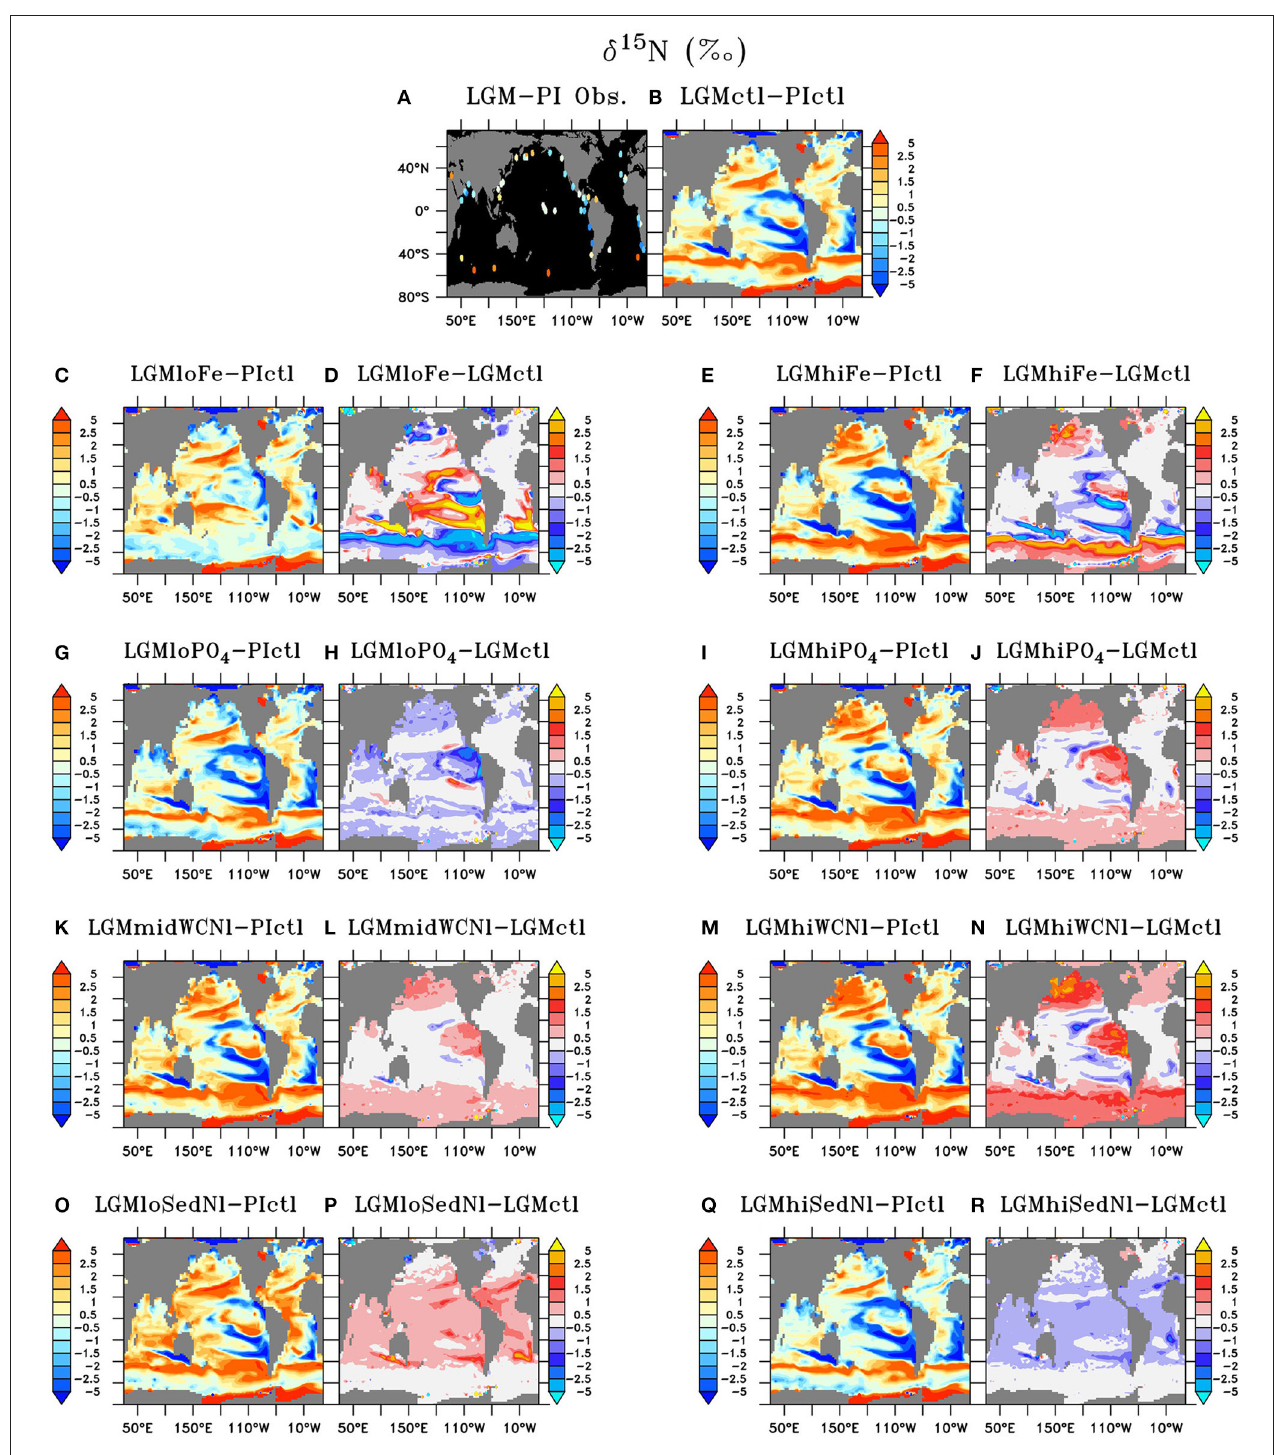
FIGURE 9 | Sedimentary δ 15 N of (A) LGM minus preindustrial observations and (B) Last Glacial Maximum control (LGMctl) minus preindustrial control (PIctl). Sedimentary δ 15 N differences of the Last Glacial Maximum simulations: (C,D) LGMloFe, (E,F) LGMhiFe, (G,H) LGMloPO 3 − 4 , (I,J) LGMhiPO 3 − 4 , (K,L) LGMmidWCNl, (M,N) LGMhiWCNl, (O,P) LGMloSedNl, and (Q,R) LGMhiSedNl minus PIctl and minus LGMctl are shown, respectively.